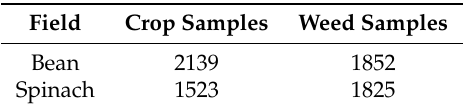
Figure 11. ROC curves of test data with weed data from the bean field exchanged with those of the spinach field. From left to right: the ROC curves computed on the bean ( a ) and spinach ( b ) test data. In the bean field, the areas under the curve (AUCs) are 91.37% for unsupervised data and 93.25% for supervised data. In the spinach field, the areas under the curve (AUC) are 82.70% for unsupervised data and 94.34% for supervised data. Supervised and unsupervised data mean, respectively, data labeled in supervised and unsupervised ways. Table 2. Number of test samples used for each